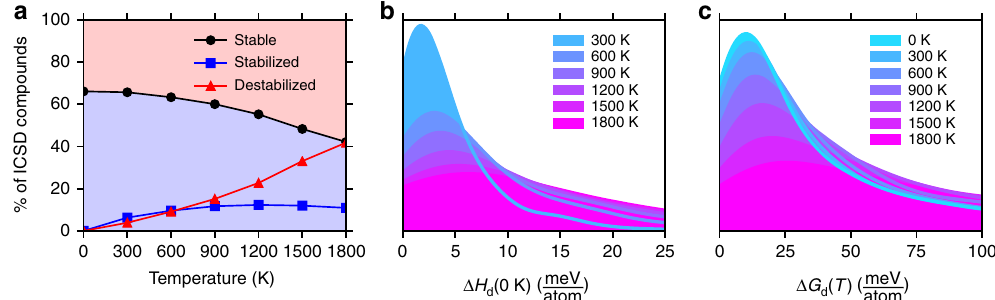
Fig. 5 Survey of temperature-dependent (meta)stability. a Fraction of ICSD compositions which are thermodynamic ground states (black), fraction of 0 K metastable compositions which are stable at T (blue), fraction of 0 K stable compositions which are metastable at T (red), b Gaussian kernel density estimate of the 0 K decomposition enthalpy for ICSD compositions which are thermodynamically metastable at 0 K but stable at T , c Gaussian kernel density estimate of the Gibbs decomposition energy at T for metastable compounds at each T . See Methods for additional details regarding